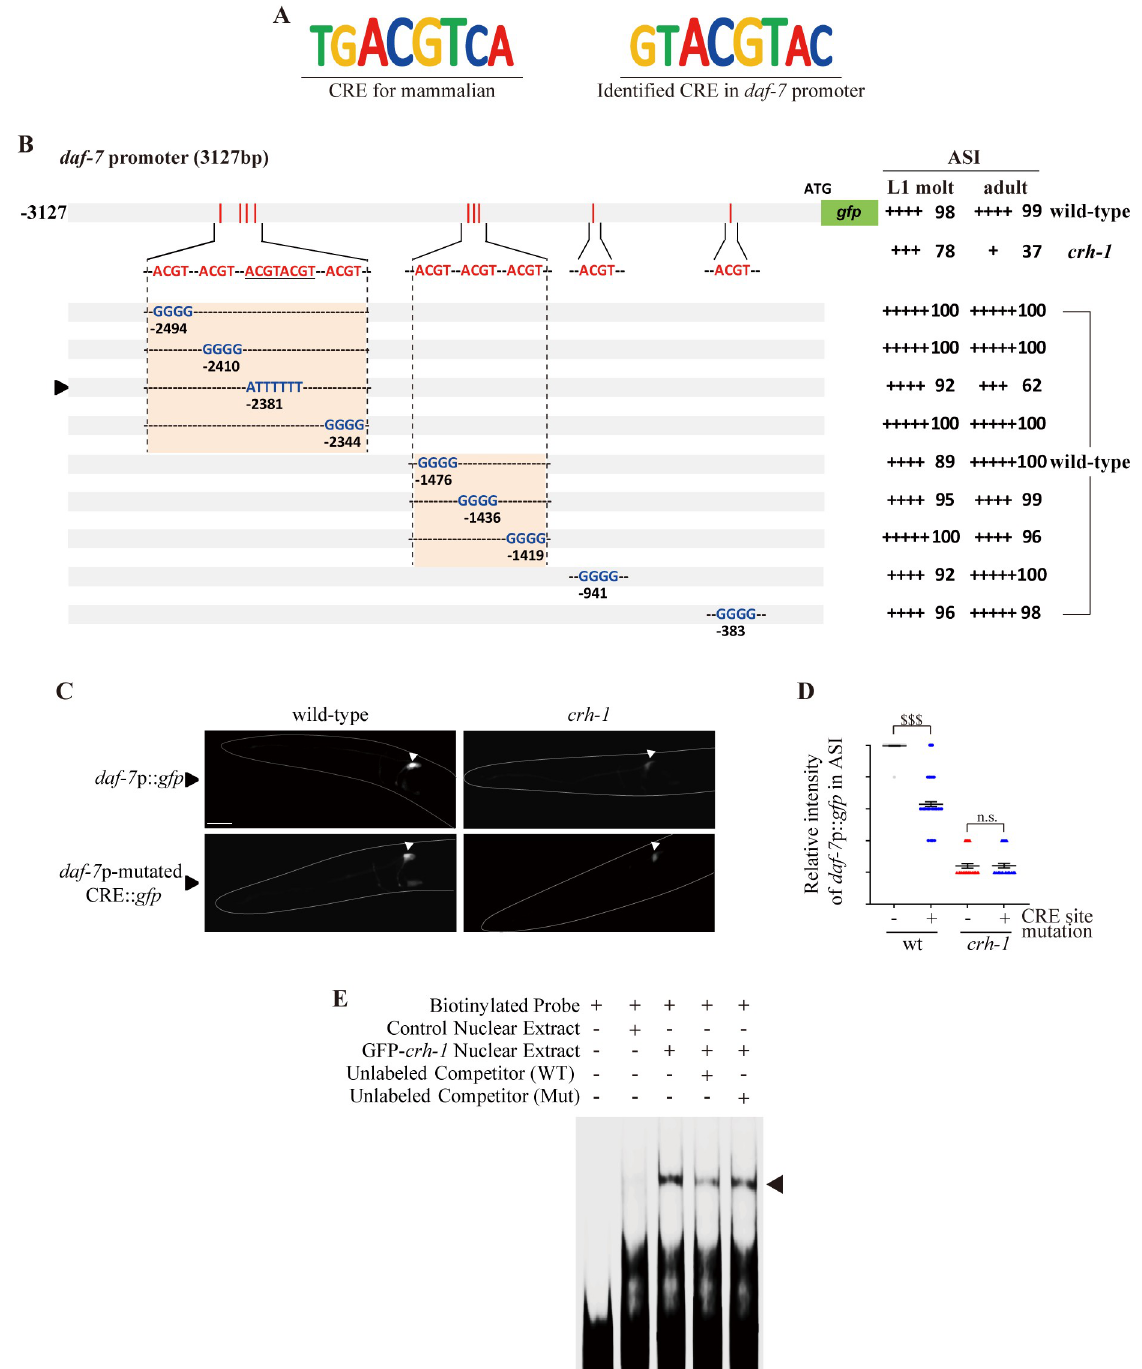
Fig 6. CRH-1 directly binds a CRE motif in the daf-7 promoter. (A) Shown are the conserved mammalian CRE motif and the newly identified CRE motif in the daf-7 promoter. (B) The percentage of transgenic animals expressing daf-7 p:: gfp reporter construct in the ASI neurons is shown. GFP fluorescence was observed either in wild-type or crh-1 mutant animals. The strength of GFP expression is indicated by the number of + symbols. Wild-type nucleotides are indicated in red, mutated nucleotides in blue. An arrowhead indicates daf-7 p- mutated CRE promoter. At least two independent extrachromosomal lines for each construct were examined. n � 30 for each. (C) Representative images of L1 larval wild-type or crh-1 mutant animals expressing daf-7 p:: gfp or daf-7 p-mutated CRE:: gfp in the ASI neurons. Scale bar: 50 μ m. (D) Scatter plot of fluorescence intensity of daf-7 p:: gfp fluorescence in the ASI neurons of adult wild-type or crh-1 mutant animals with (+) or without (-) of CRE site mutation. The median is indicated by a horizontal line. Each dot is the fluorescence intensity of